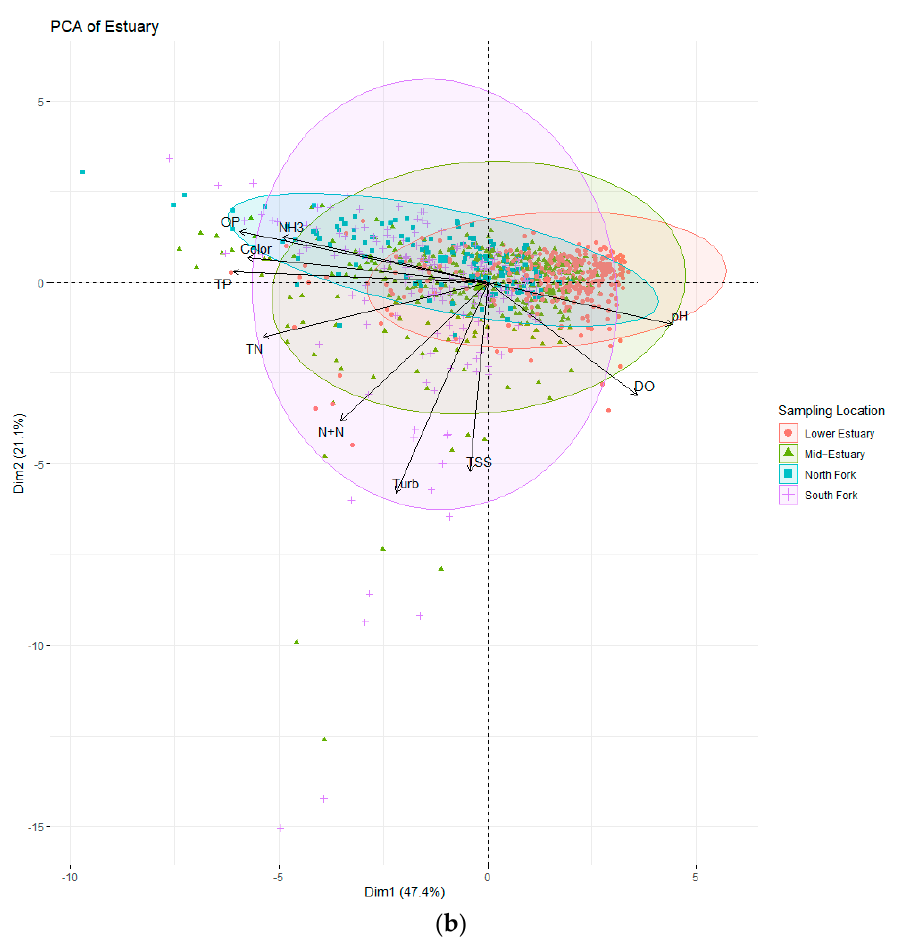
Figure 3. ( a ). Biplot of PCA of samples taken from the four main surface tributaries. ( b ). Biplot of PCA of samples taken from the St. Lucie Estuary.